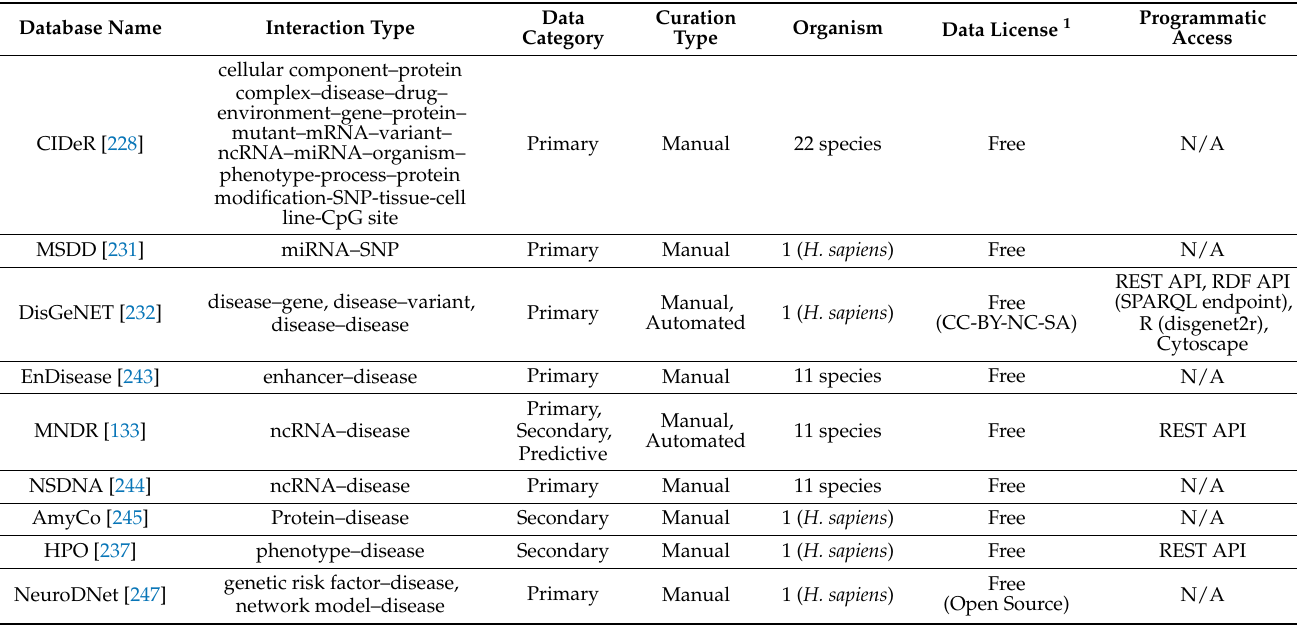
Table 8. Disease-related